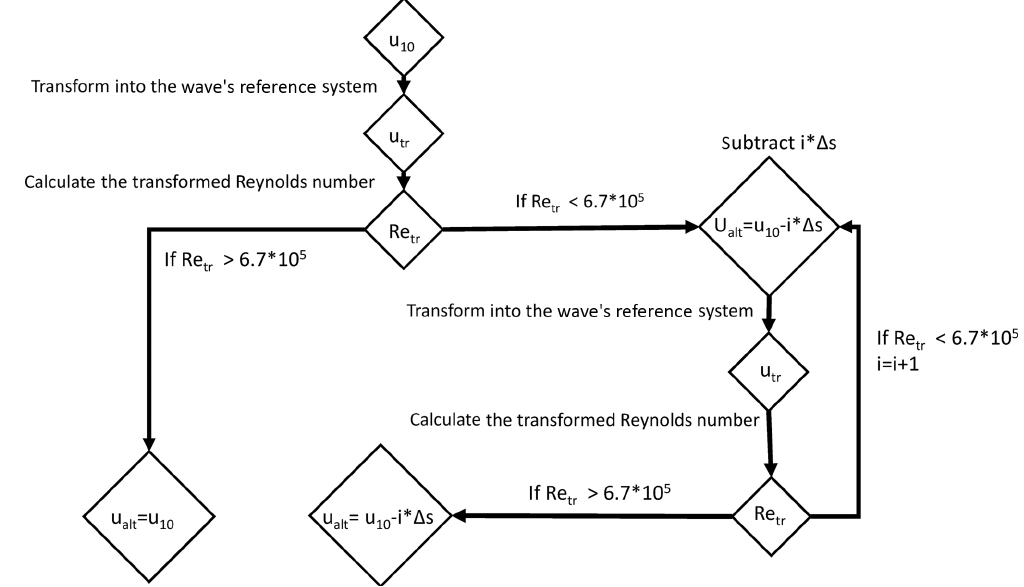
Figure 1. Work flow of the gas transfer suppression model. In the case of suppressed gas transfer, the output is the adjusted wind speed u alt , which can then be used in gas transfer parameterizations. The step size (cid:49)s can be adapted freely, but considerations of resolution and computing power have to be made. We set (cid:49)s = 0 . 3ms − 1 for this